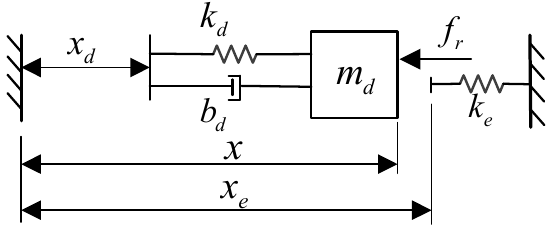
Figure 13. Simplified model of robot–environment contact.